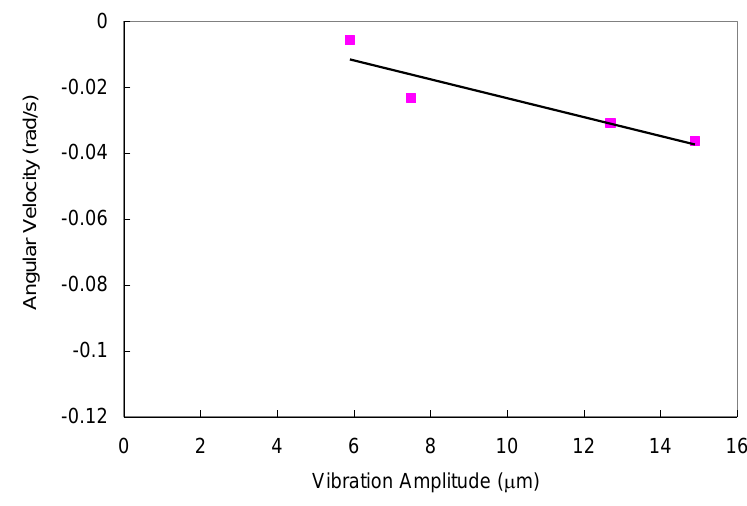
Figure 12. Angular velocity versus vibration amplitude at 686 Hz.